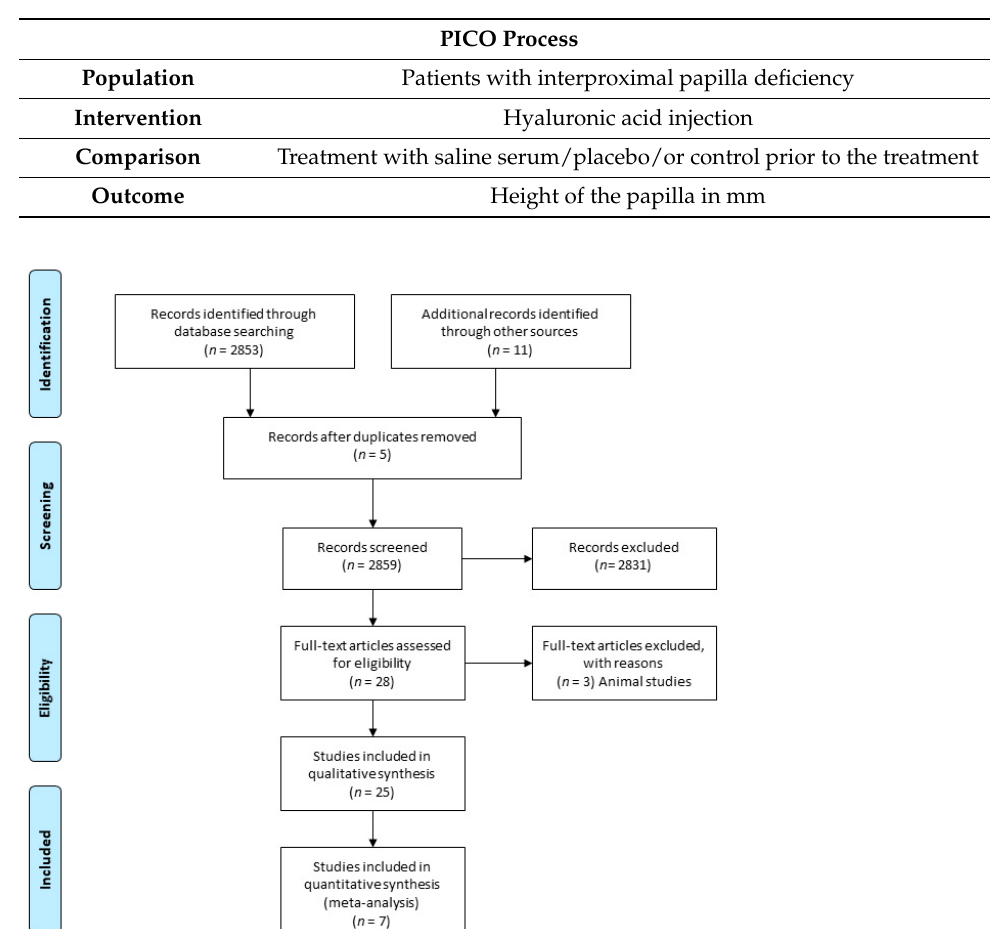
Figure 1. Flowchart of the process of searching for and selecting articles in databases.